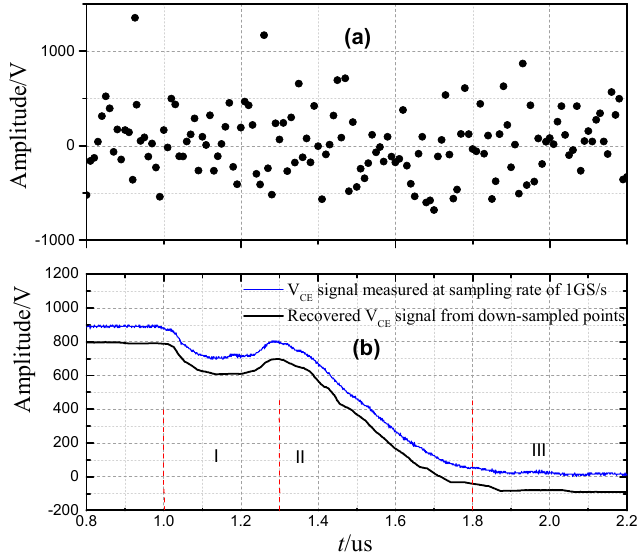
Figure 7. Reconstruction of V CE signal during IGBT turn-on transition: ( a ) random under-sampling points (100 MS/s); ( b ) comparison of the recovered V CE signal and original V CE signal.